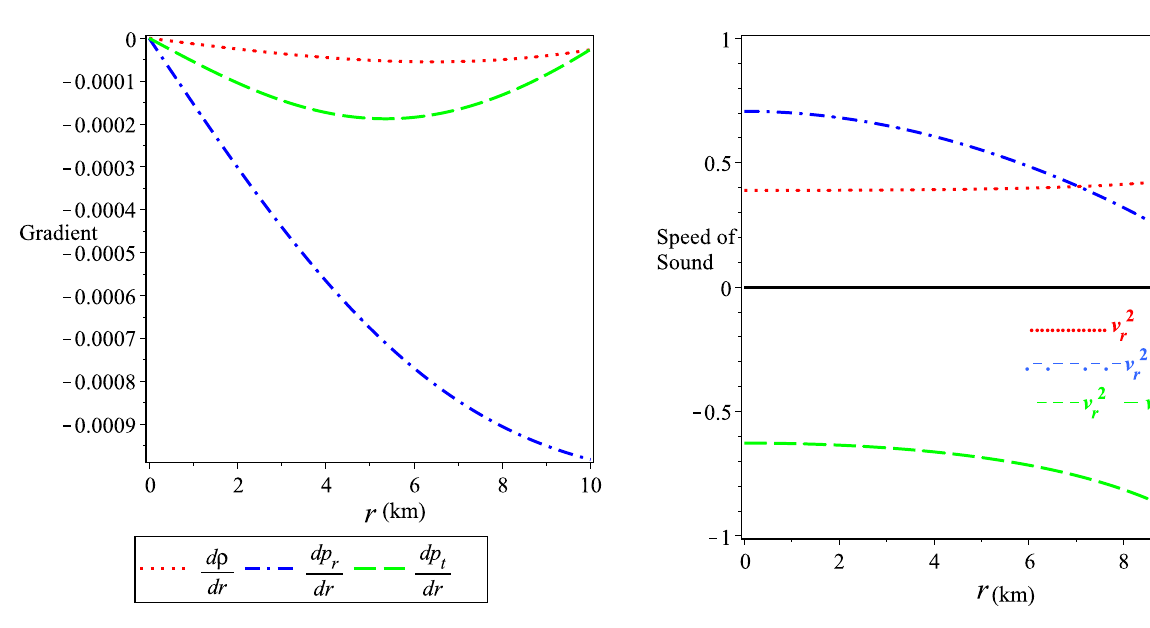
Fig. 5 Plots of the radial and tangential sound speeds vs the radial coordinate r in Km using the PSR J 1614-2230 constraints This result confirms the non-violations of causality condition in the interior of the star. Figure 6 represent the behavior of the energy